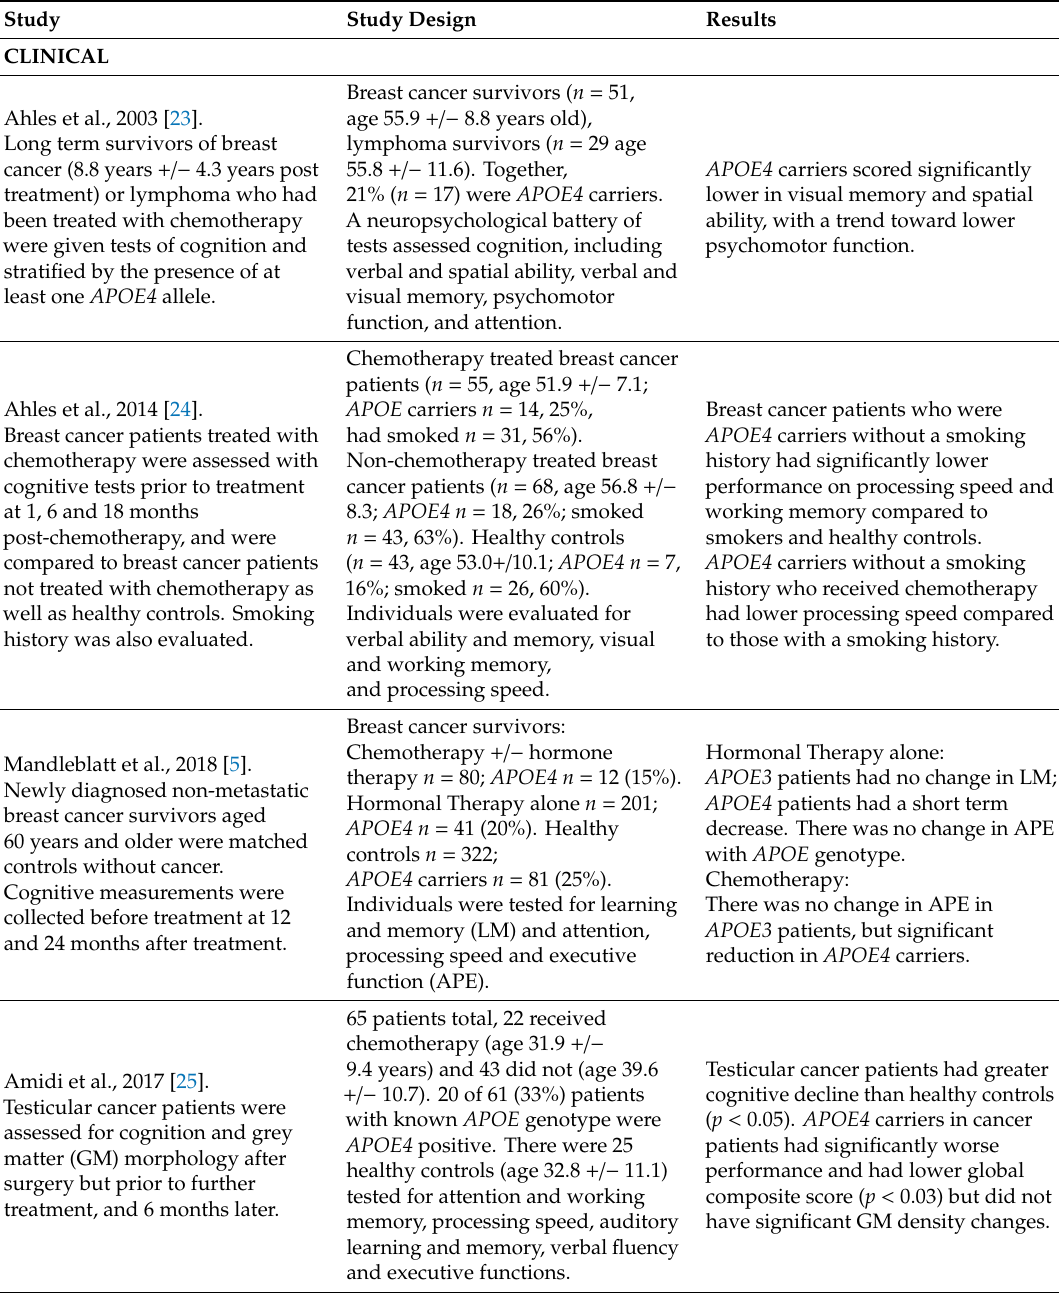
Table 1. Clinical and pre-clinical studies showing e ff ects of APOE4 on